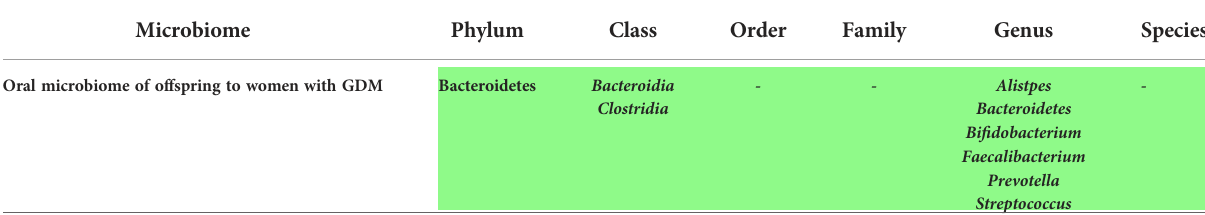
TABLE 4 Summary of the oral microbiome alterations in offspring to patients with GDM ( = Increased, = Decreased, =